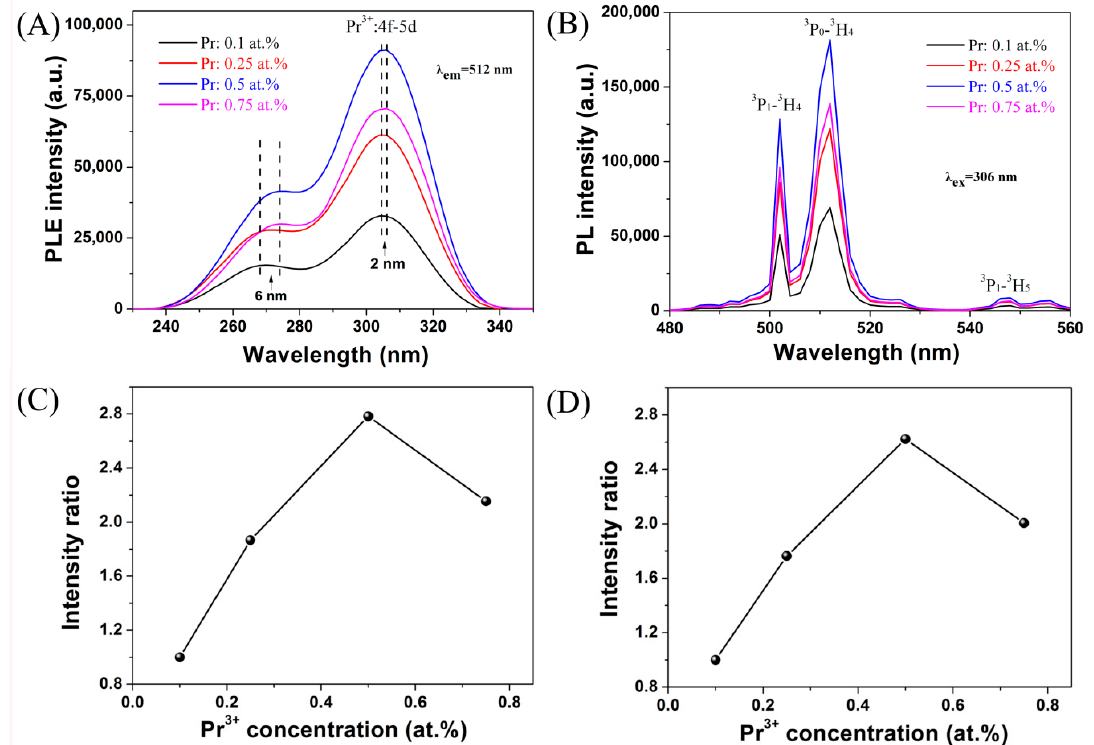
Figure 4. Photoluminescence excitation (PLE) ( A ) and photoluminescence (PL) ( B ) spectra of (Gd 1 − x Pr x ) 2 O 2 S ( x = 0.001 ‒ 0.0075) phosphor powders, PLE intensities of the 306 nm excitations normalized to 1 for the lowest value ( C ), and PL intensities of the 512 nm emissions normalized to 1 for the lowest value ( D ).